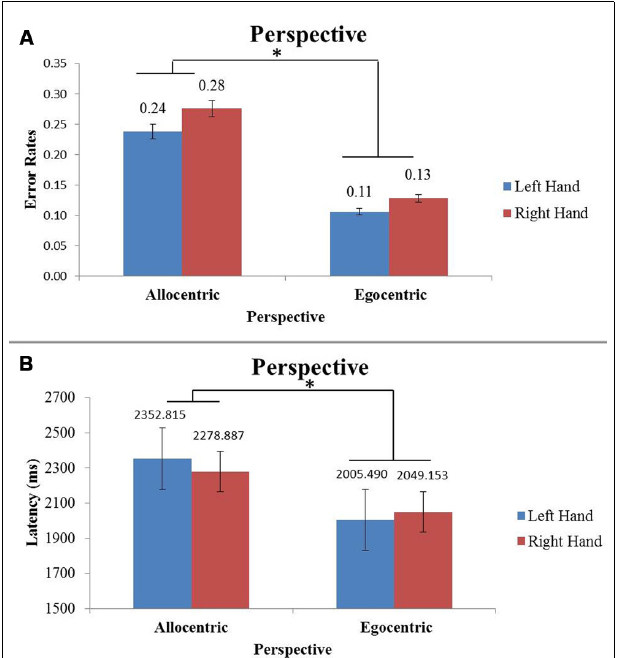
FIGURE 5 | Figure (A) shows average error rates for allocentric and egocentric images. Figure (B) shows the average latency for allocentric and egocentric images.The x-axis represents perspective of the image separated by hand viewed. Perspective is statistically significant (* p < 0.05) between the error rate and latency graphs with egocentric images having the lowest latency and error rates.